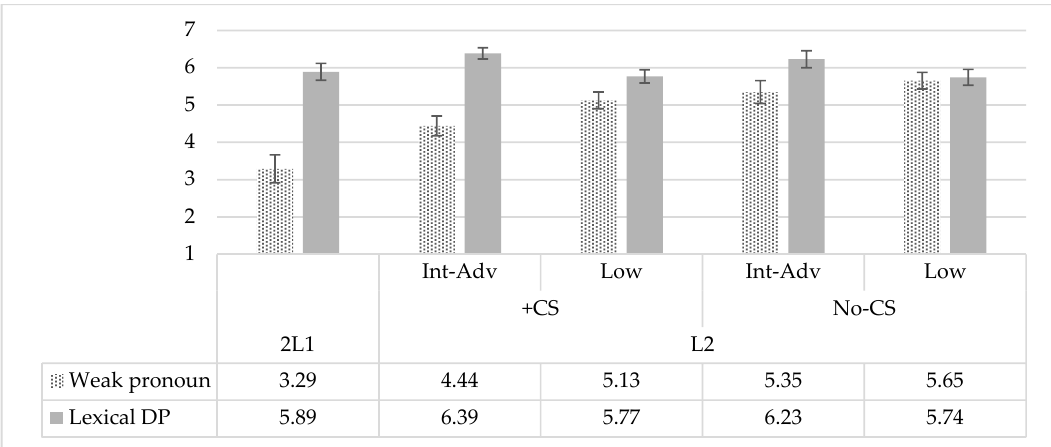
Figure 9. Code-switched English-to-Spanish subject stimuli ratings by group and type.